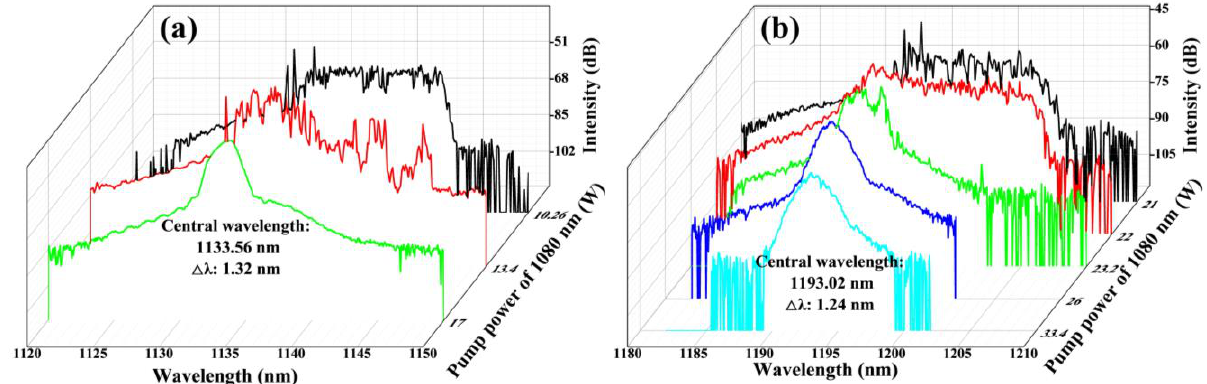
Figure 5. ( a ) The evolution of 1133-nanometer first-order Raman laser. ( b ) The evolution of 1193- nanometer second-order Raman laser.